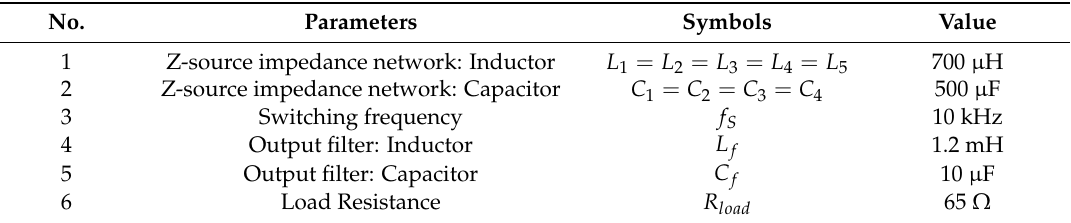
Table 2. Simulation parameters for the